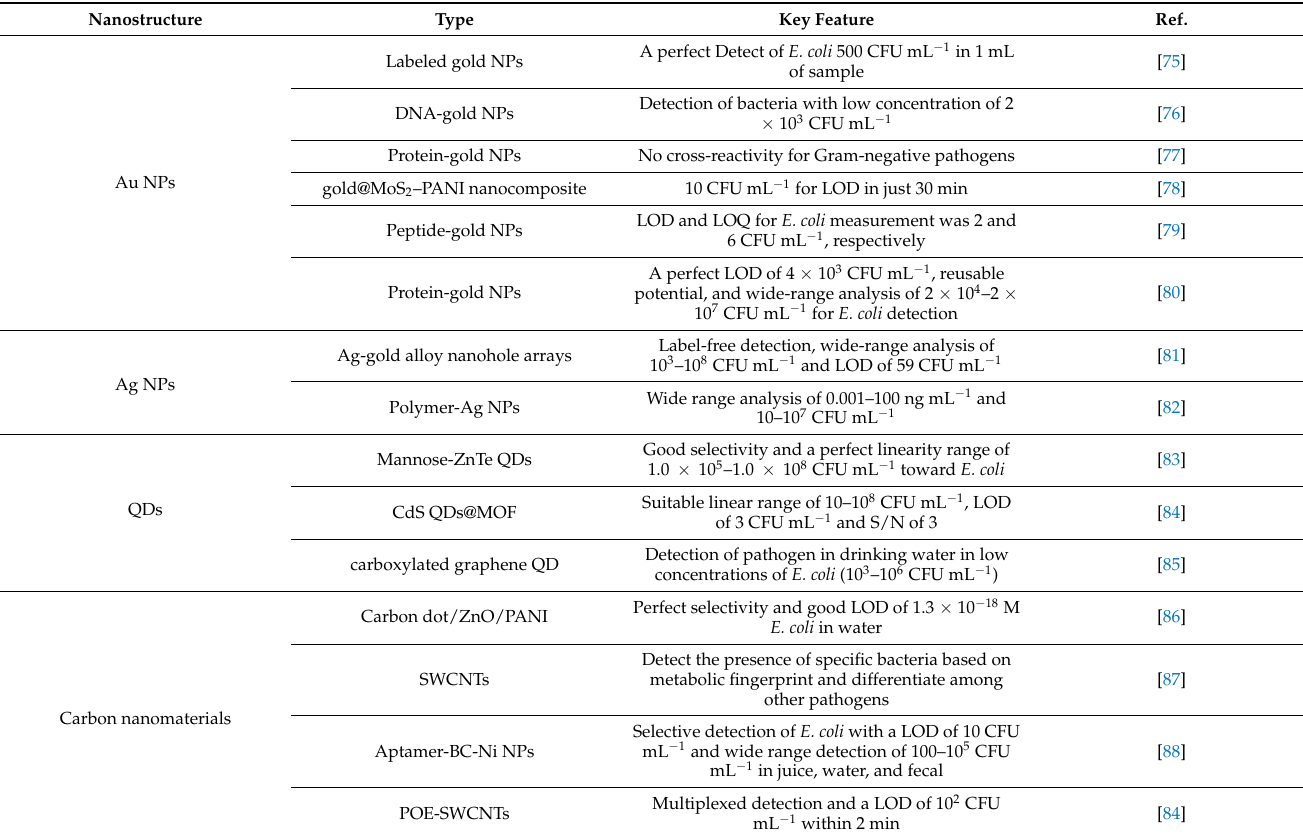
Table 1. Summary of different nanomaterials in the detection of E. coli